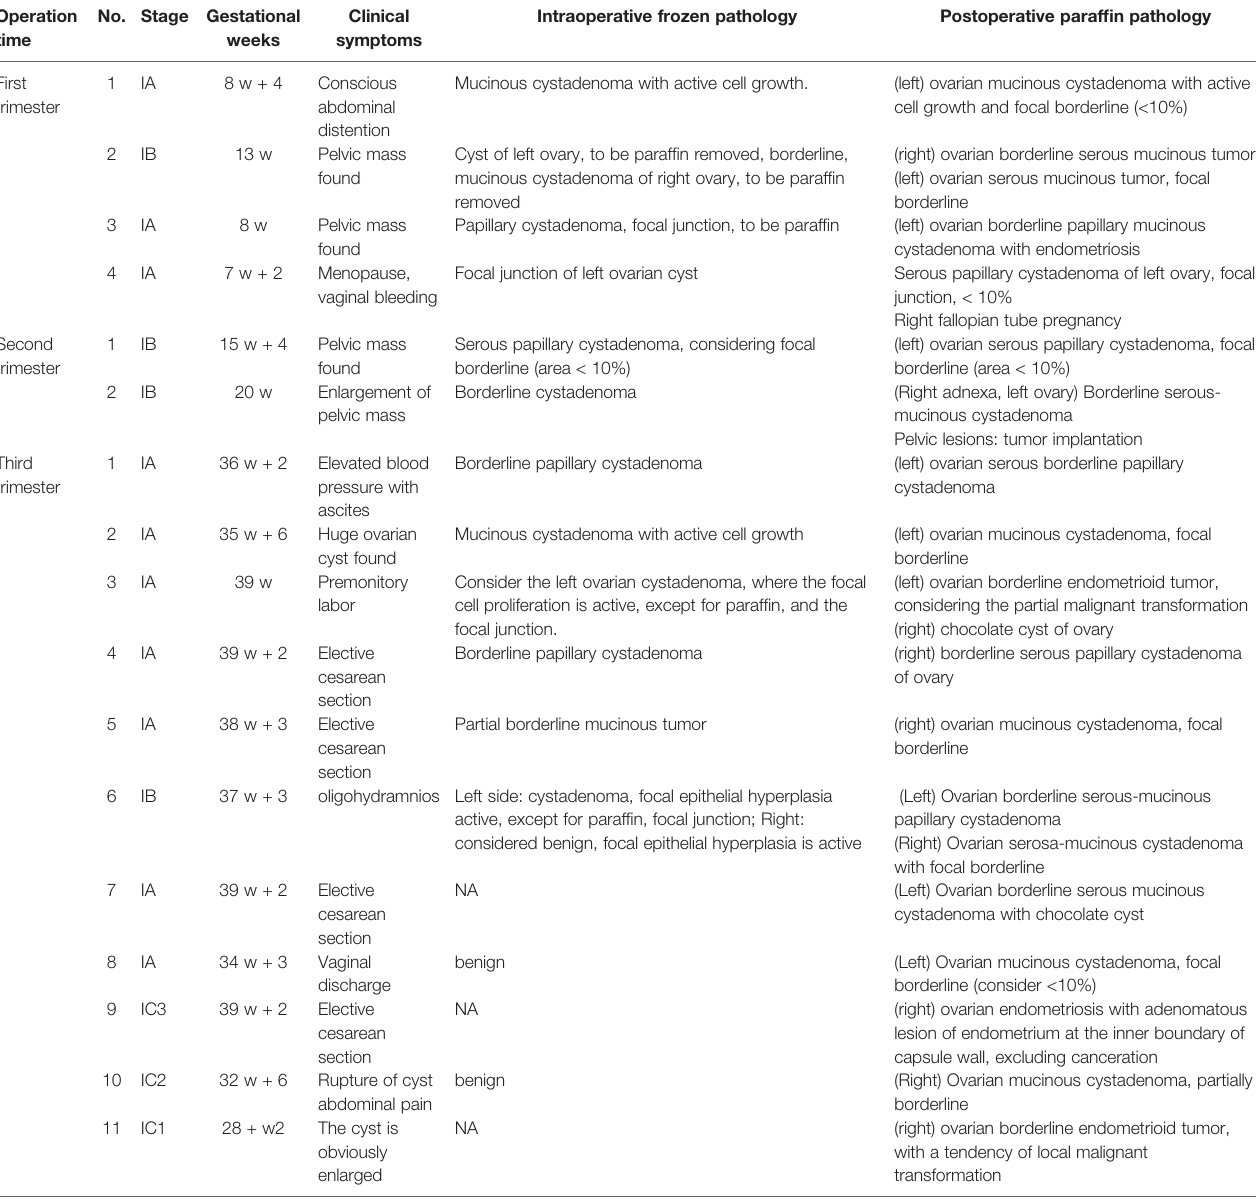
TABLE 3 | Intraoperative frozen pathology and postoperative paraf fi n pathology. Operation